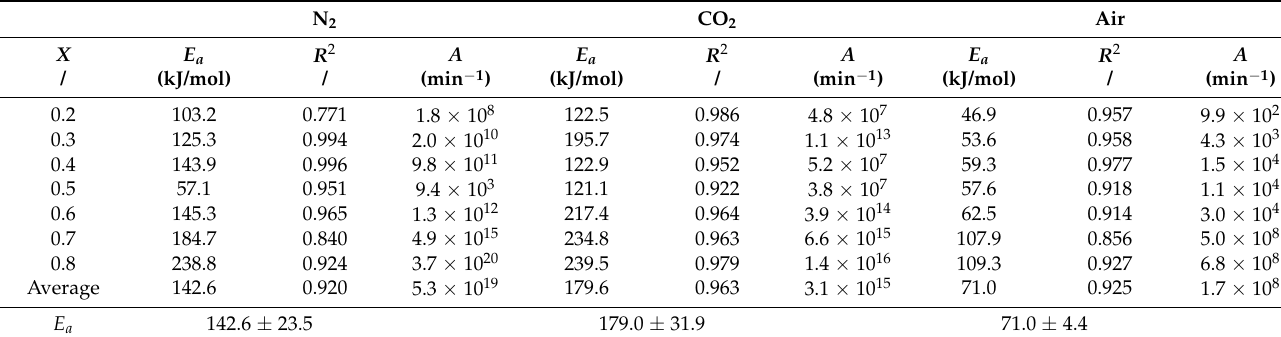
Table 7. Kinetic parameters obtained by KAS method.